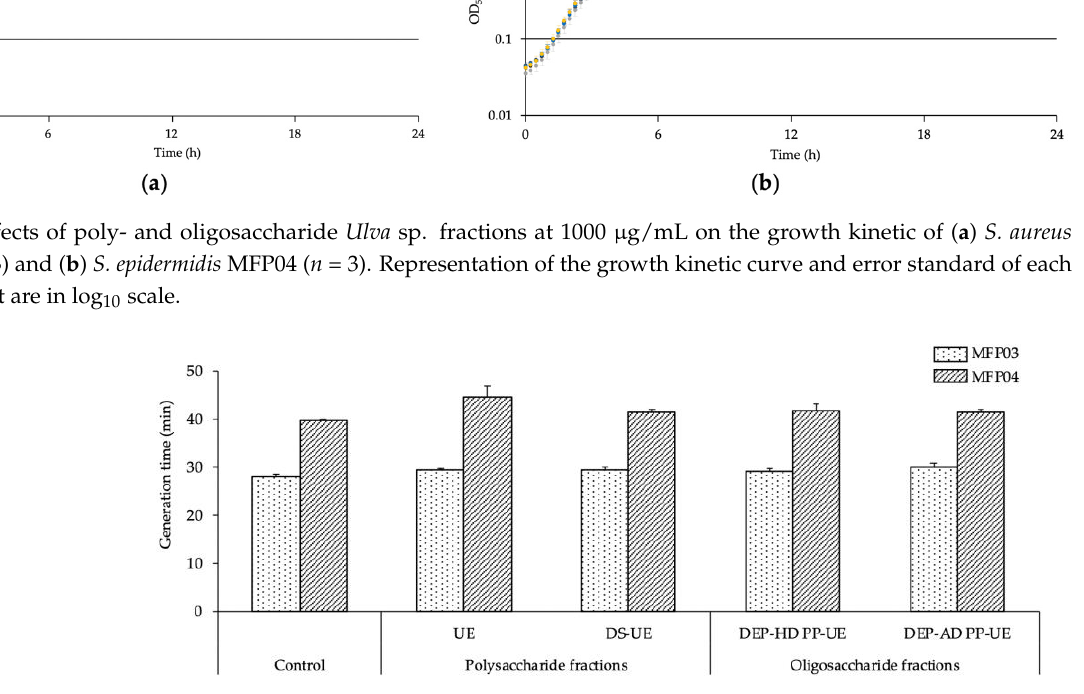
Figure 2. Effects of poly- and oligosaccharide Ulva sp. fractions at 1000 μg /mL on the generation time of S. aureus MFP03 ( n = 3) and S. epidermidis MFP04 ( n = 3). No statistically significant differences were observed in comparison with the control.